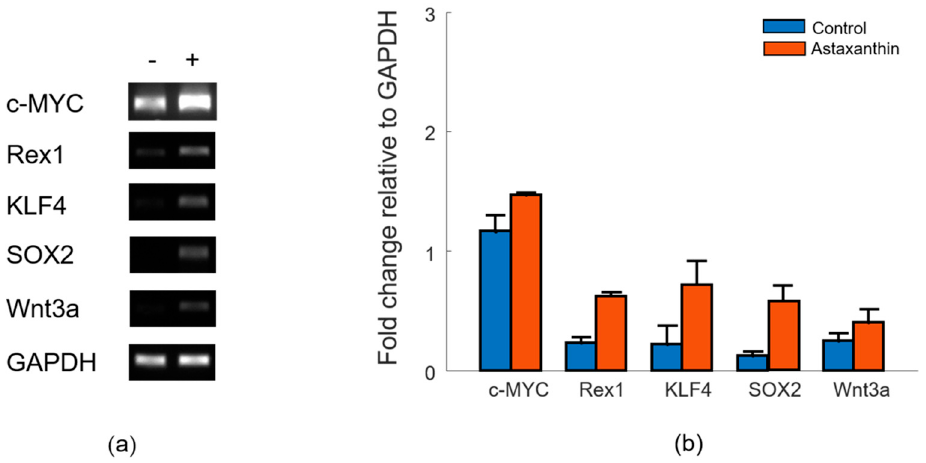
Figure 2. RT-PCR of adipose-derived mesenchymal stem cells cultured with and without astaxanthin in vitro. ( a ) Astaxanthin (0.5 ng / ml)-enhanced expression that related proliferation and cell renewal. ( b ) Quantified gene expression in bar graph normalized to GAPDH. Data are presented as the mean ± standard deviation (n = 3).